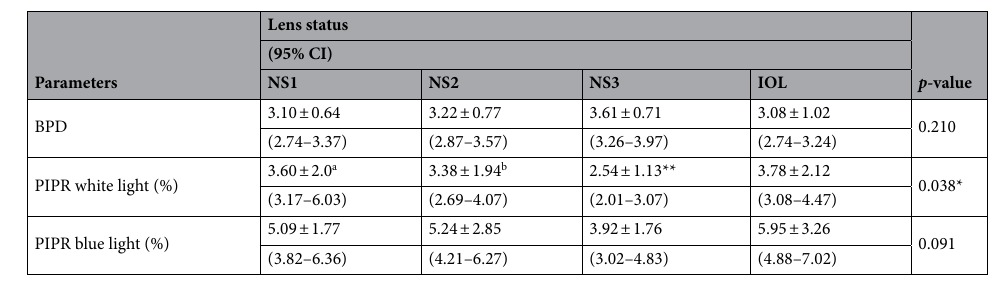
Table 3. Comparison of pupillometry parameters between nuclear cataract and IOL . Data are mean ± s.d. * p < 0.05, compared to IOL (Kruskal–Wallis test). CI confidence interval, BPD baseline pupil diameter (mm), IOL intra-ocular lens, NS nuclear sclerosis (Emery–Little classification), PIPR post-illumination pupillary response, expressed as % constriction from BPD, s.d. standard deviation. a p = 0.541. b p = 0.878. ** p = 0.037 (vs IOL, Steel–Dwass